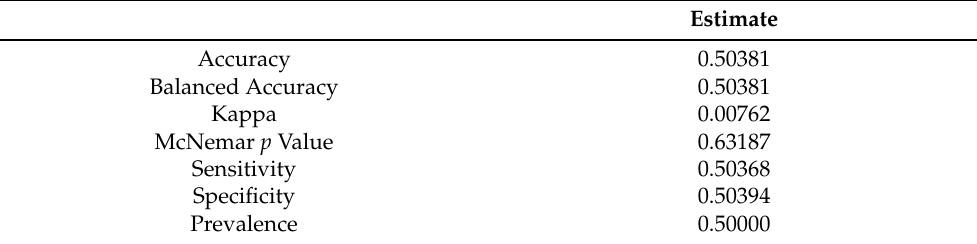
Table 7. Confusion statistics for a prediction model aimed at discriminating between synthetic records and true